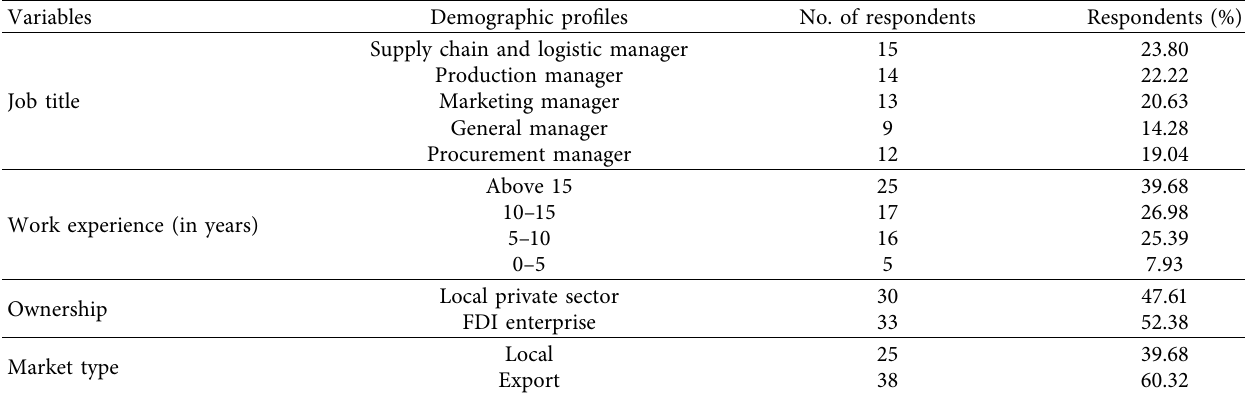
Table 6: Demographic information of